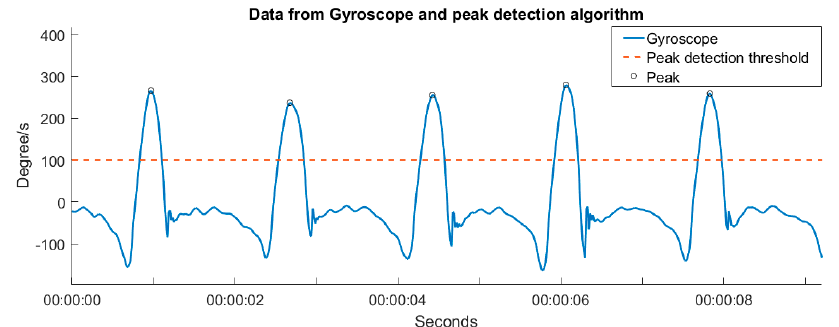
Figure 2. A typical sample of the Shimmer 3 data based on the walking speed of 2 km/h, and the corresponding peaks found by the algorithm.